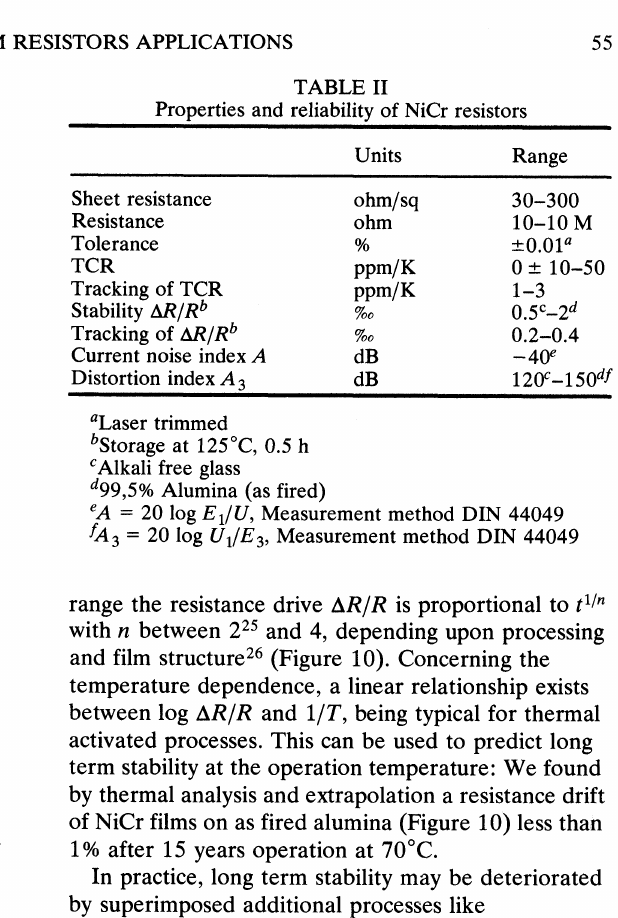
TABLE II Properties and reliability of NiCr resistors